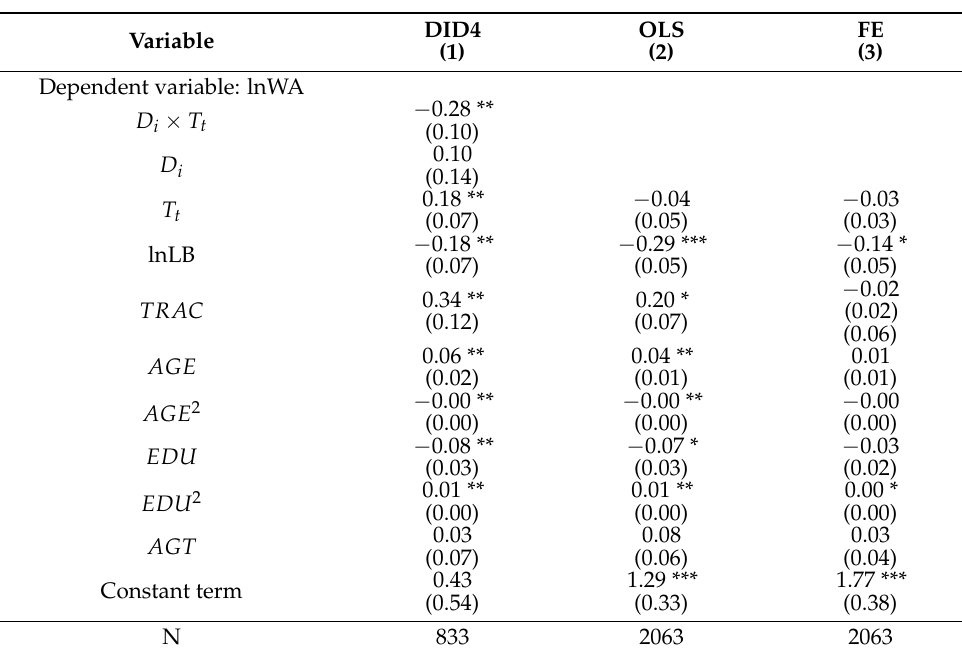
Table A2. Estimation results of the DID, OLS, and FE models.